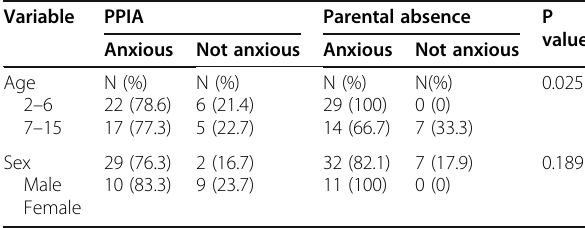
Table 6 Association between age groups, and sex of children in both study groups to anxiety at induction of anaesthesia Variable PPIA Parental